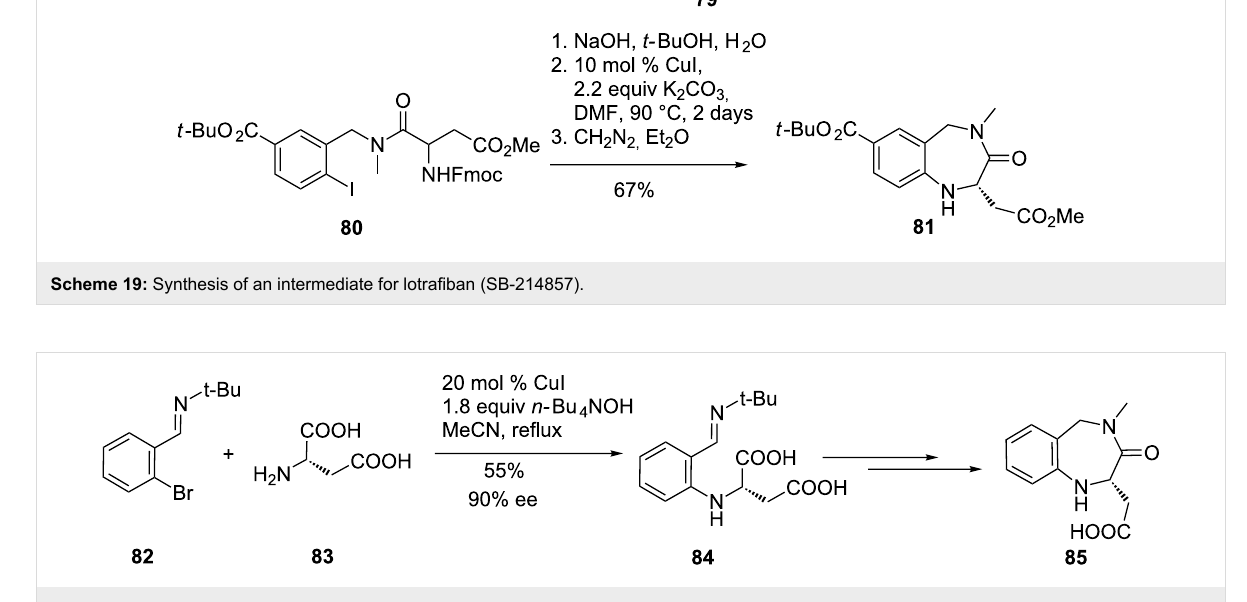
Scheme 20: Intermolecular effort towards